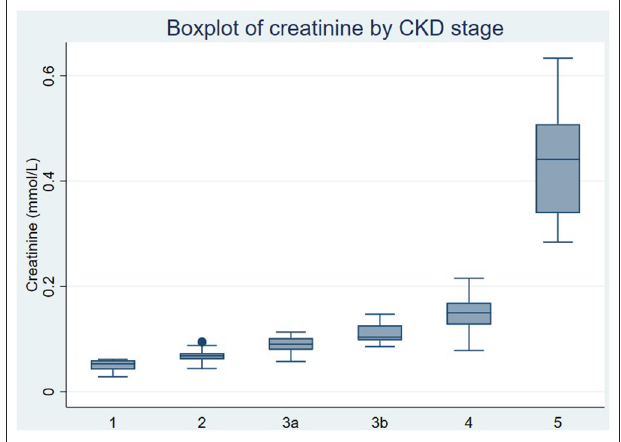
FIGURE 3 | Boxplot of creatinine by chronic kidney disease (CKD)